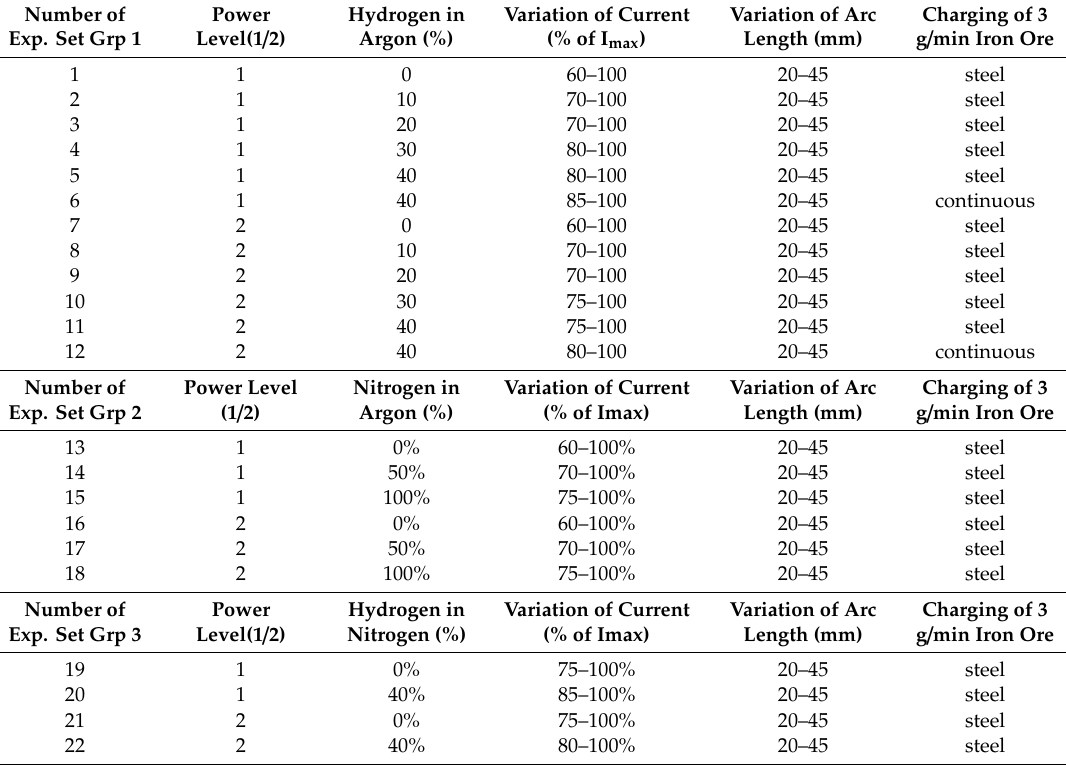
Table 4. Experimental table for the evaluation of the arc stability